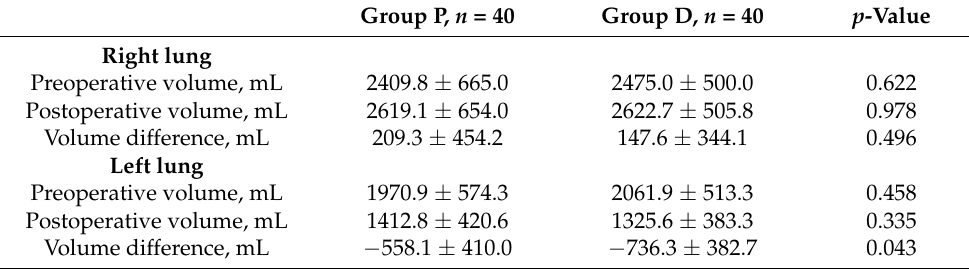
Table 2. The change in right and left lung volume between two groups.